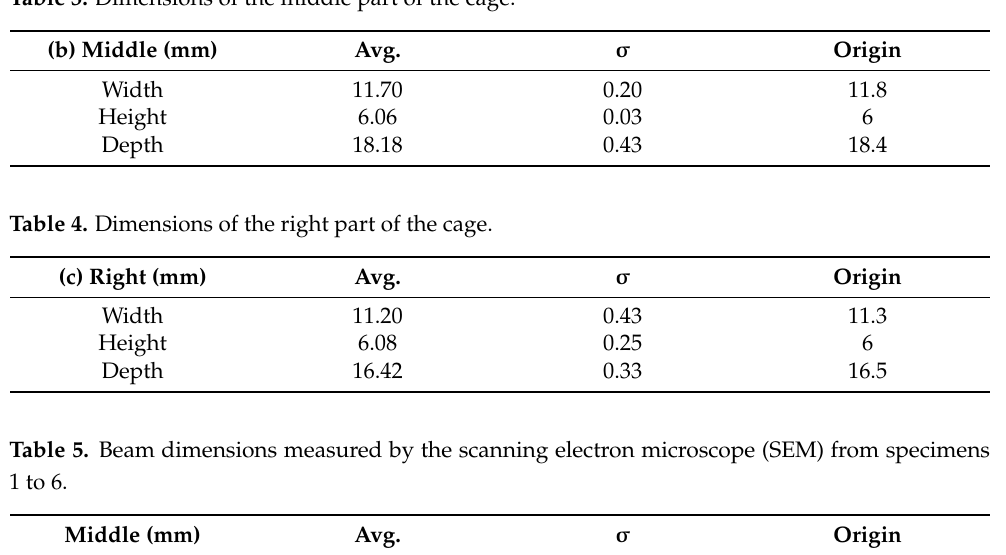
Table 3. Dimensions of the middle part of the cage.